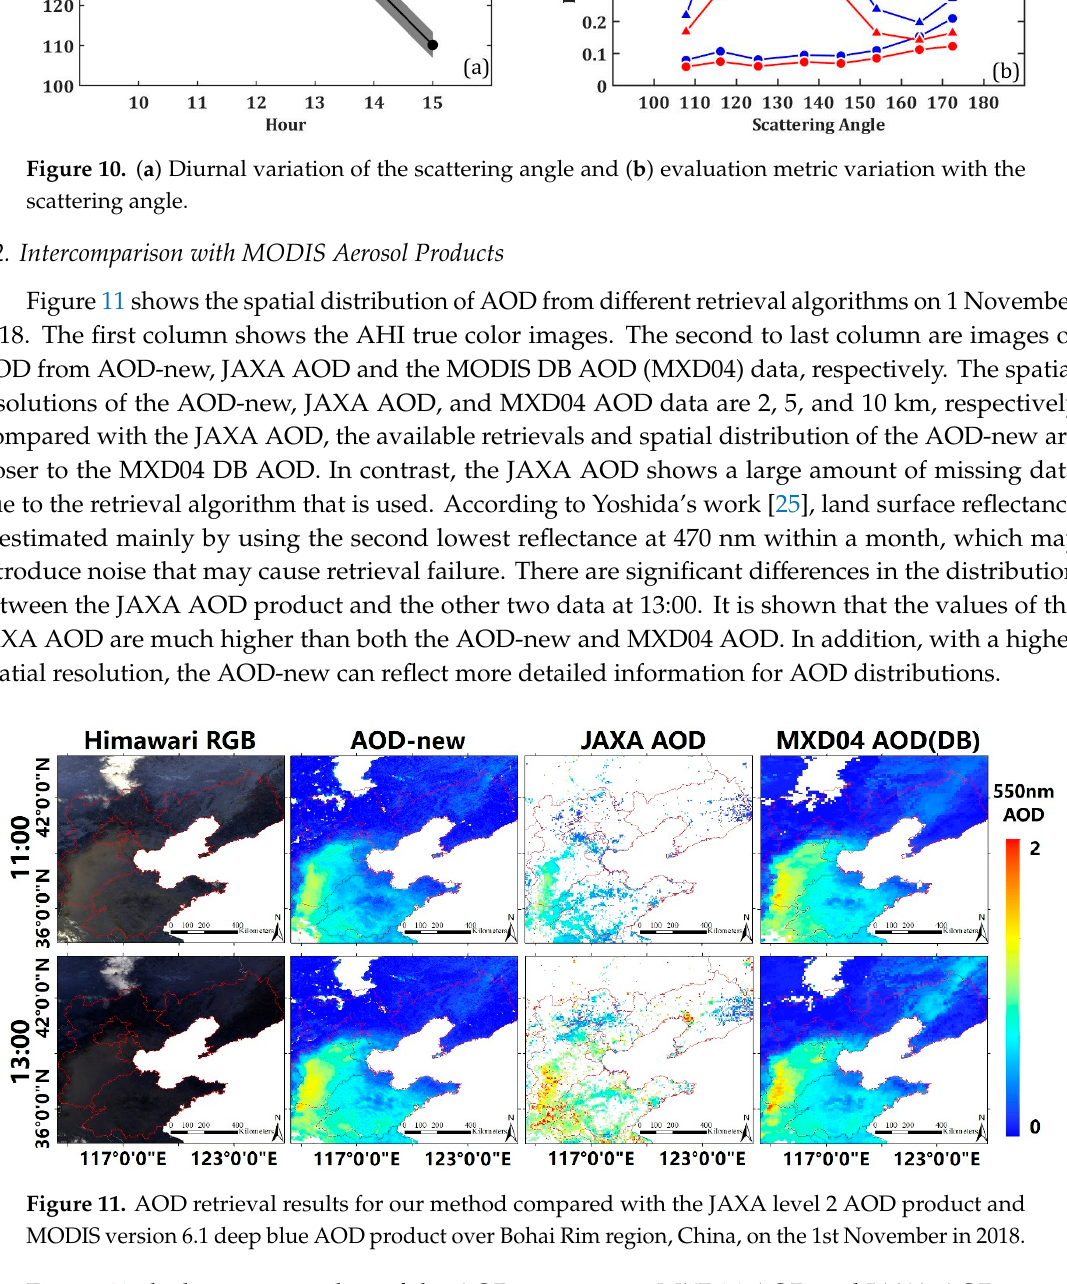
Figure 10. ( a ) Diurnal variation of the scattering angle and ( b ) evaluation metric variation with the scattering angle.